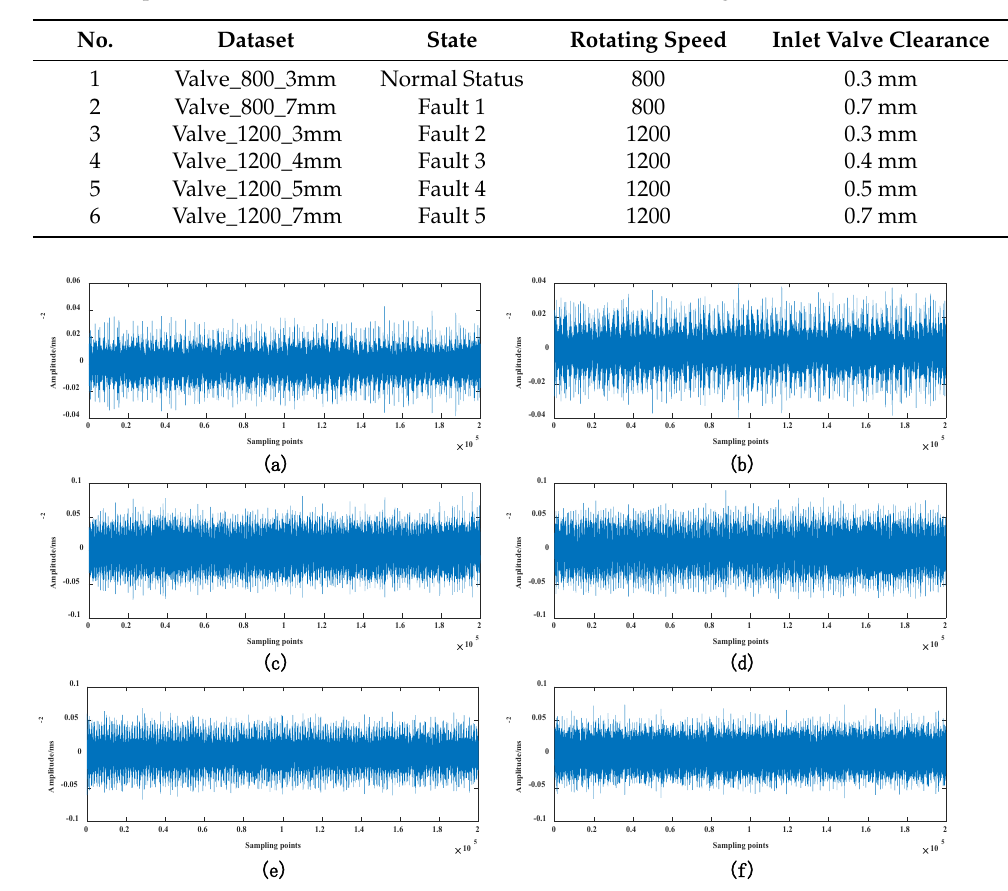
Figure 3. Experimental dataset: ( a ) Valve_800_3mm; ( b ) Valve_800_7mm; ( c ) Valve_1200_3mm; ( d ) Valve_1200_4mm; ( e ) Valve_1200_5mm; and ( f ) Valve_1200_7mm.